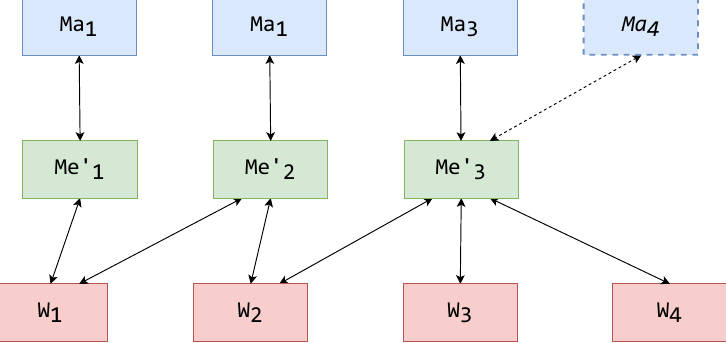
Figure 16. Scenario 1 outcome on a MMW